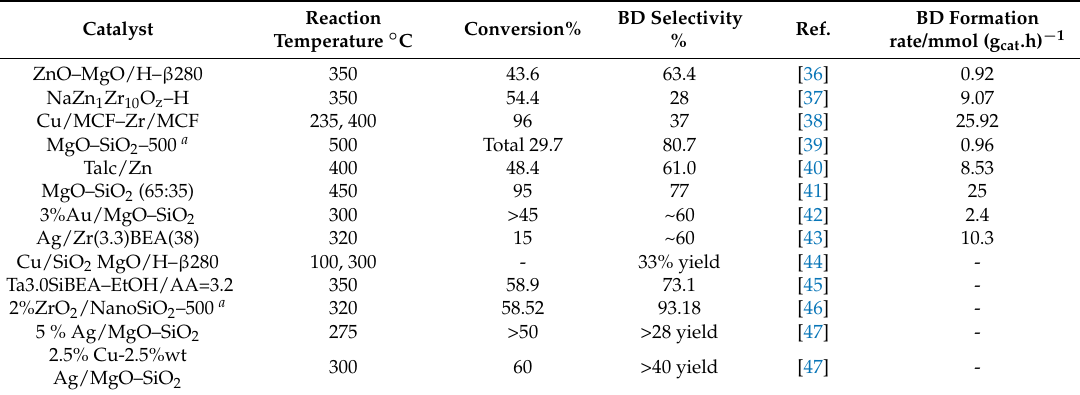
Figure 2. Synthesis of BD from ethanol. Route ( a ) was proposed by Ipatiev at al. [18]; Route ( b ) was proposed by Ostromyslensky at al. [54]. Table 1. Synthesis of BD from ethanol over various catalyst systems recently.